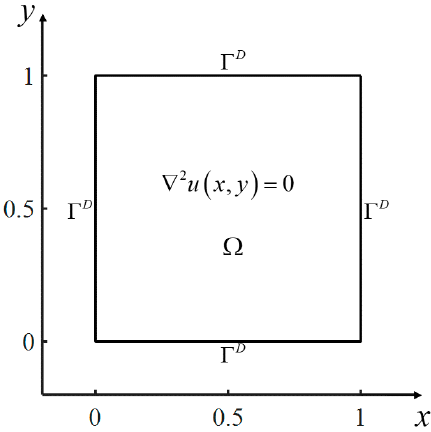
Figure 3. Schematic diagram of computational domain in Case 1.